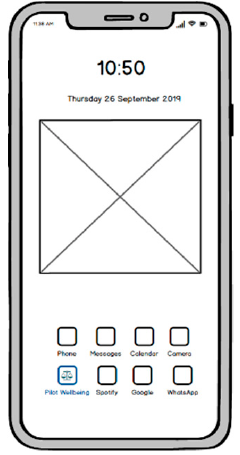
Figure A7. Pilot phone: dashboard.